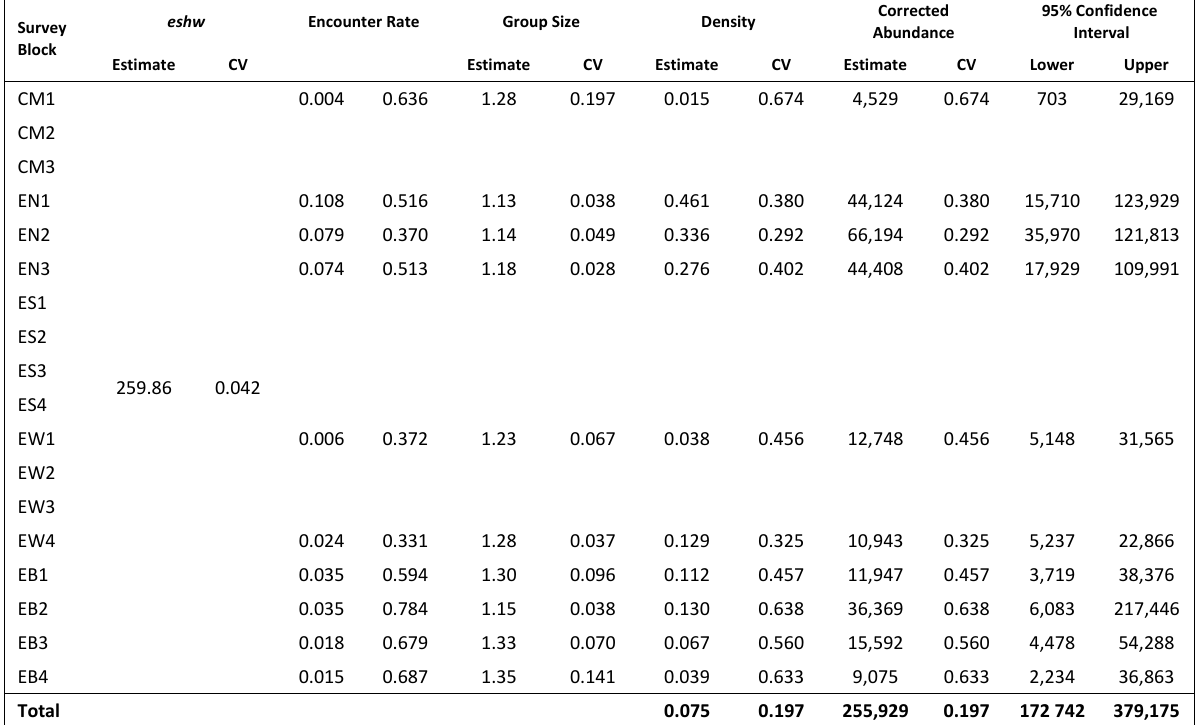
Table 10. Estimated density and abundance of harbour porpoises. The eshw (effective search half width (m)) was estimated for the entire study area. Encounter rate, group size, density, abundance, and upper and lower confidence limits were estimated by block and corrected for perception bias, with the estimated p